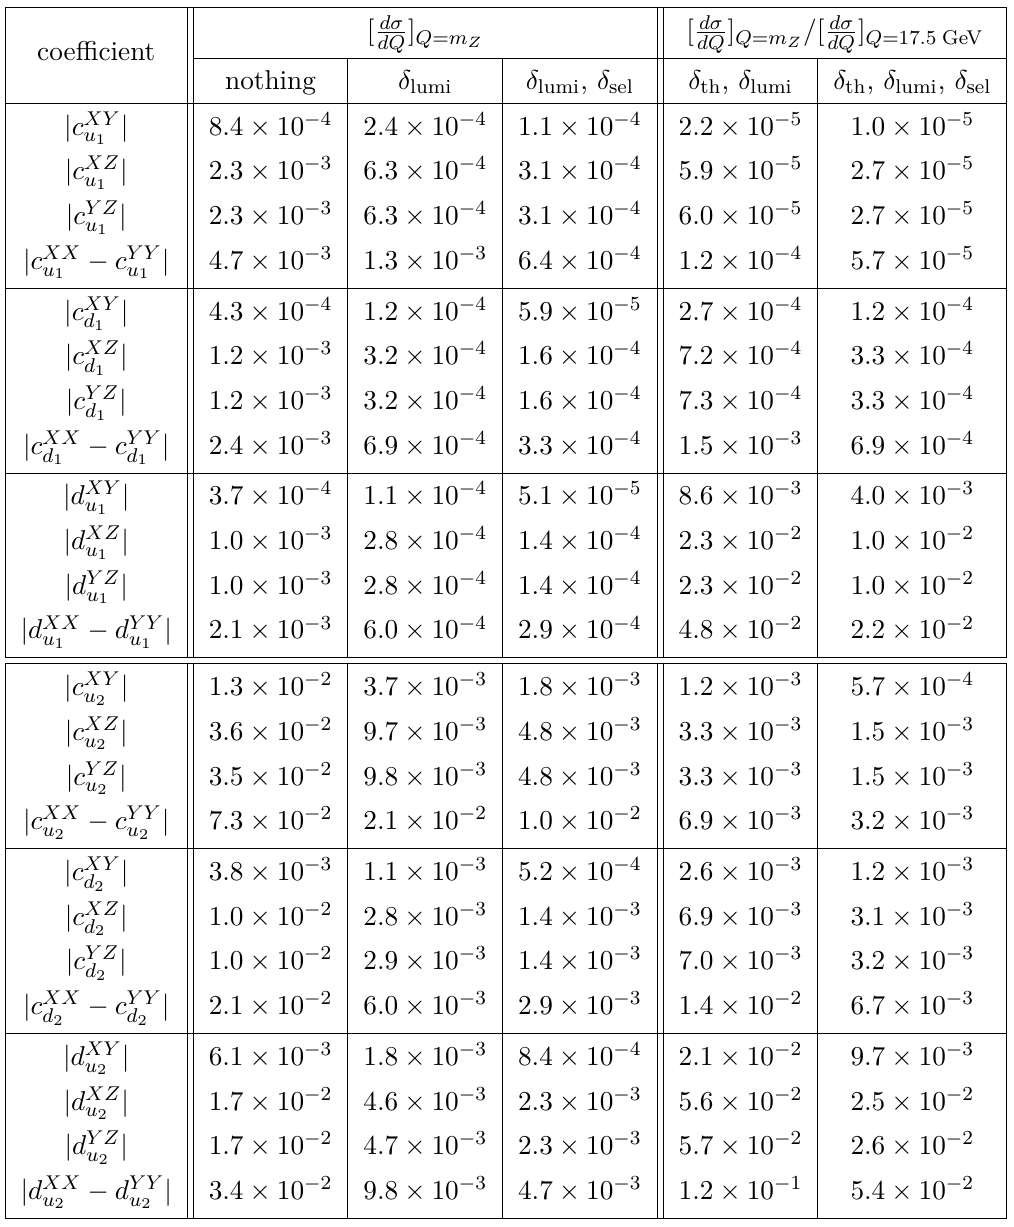
Table 5 . Expected best constraints of the time-dependent coefficients in the ( c u for Q = m Z and Q = 17 . 5 GeV . See the captions in table 2 and table 4 for further